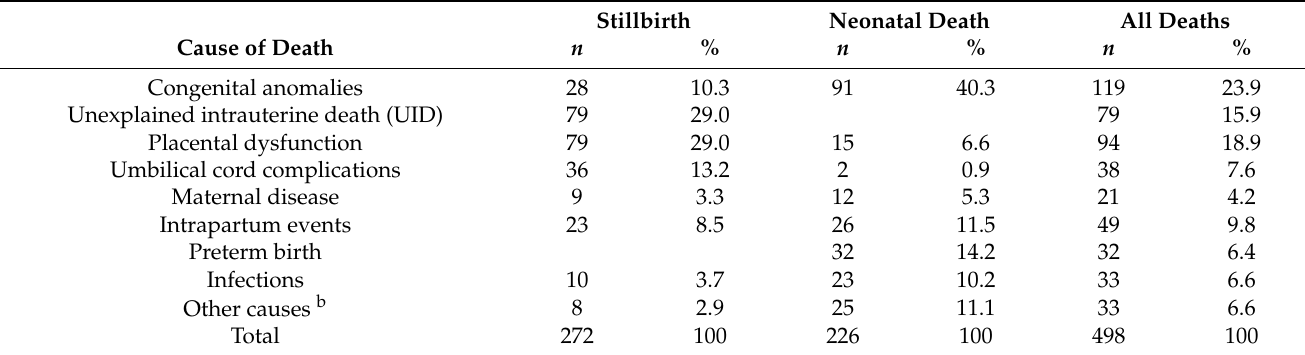
Table 1. Distribution of cause-specific stillbirth and neonatal death in 272 late stillbirths (cid:61) 28 GA weeks and 226 neonatal deaths a